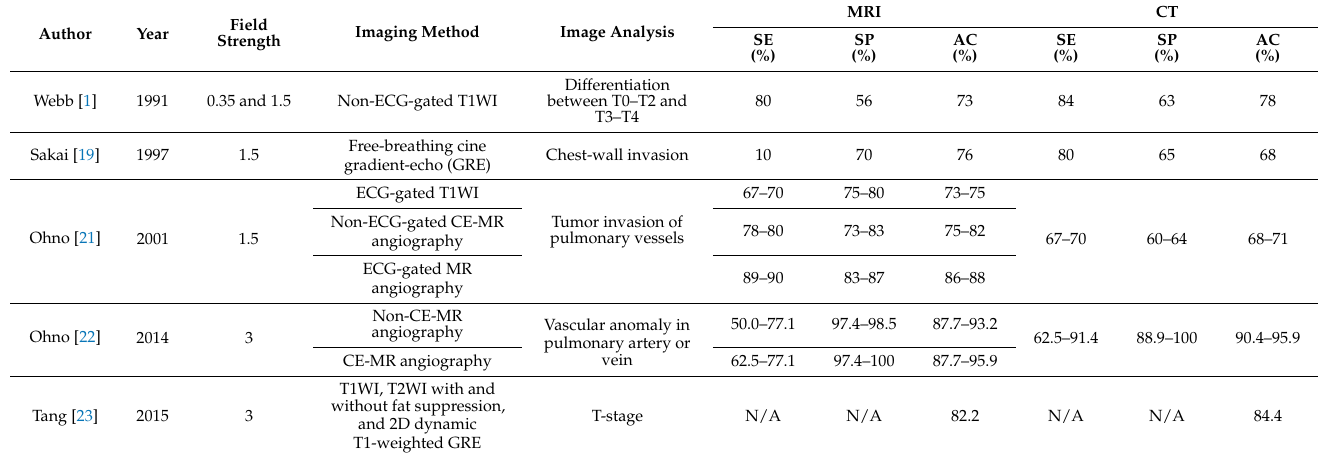
Table 2. Summary of diagnostic performance of T-factor assessment using dedicated chest